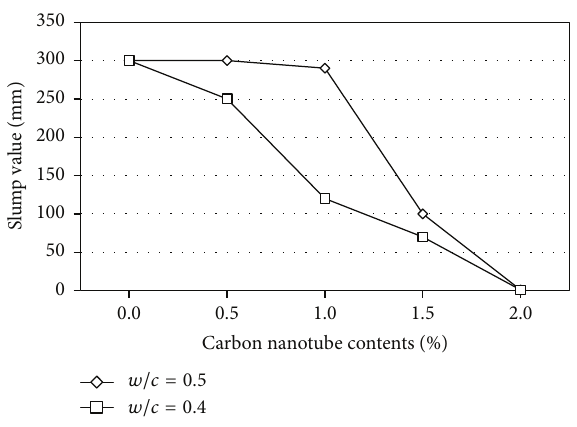
Figure 2: Slump test results of